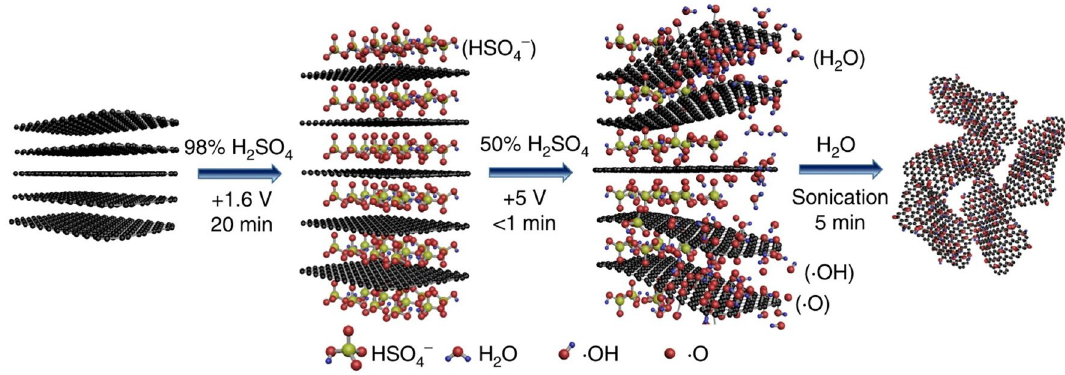
Fig. 3 The preparative process of graphene oxide (GO) via the water electrolytic oxidation process. Reproduced with permission from Ref.